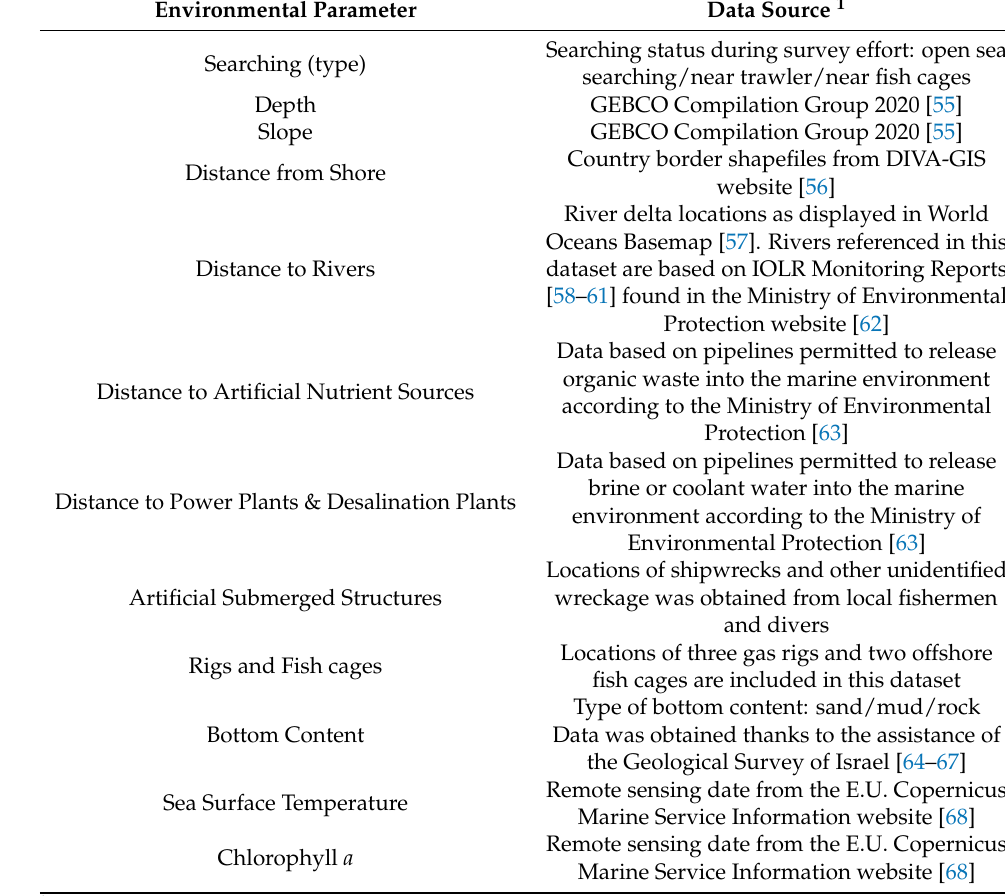
Table 1. Environmental parameter names, sources and methods of